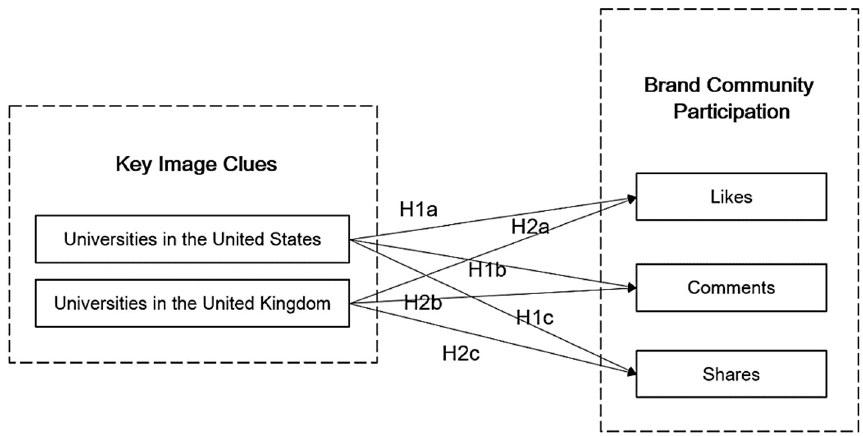
Figure 1. Extended research model.